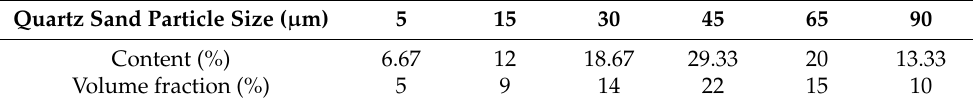
Table 2. Particle size distribution.